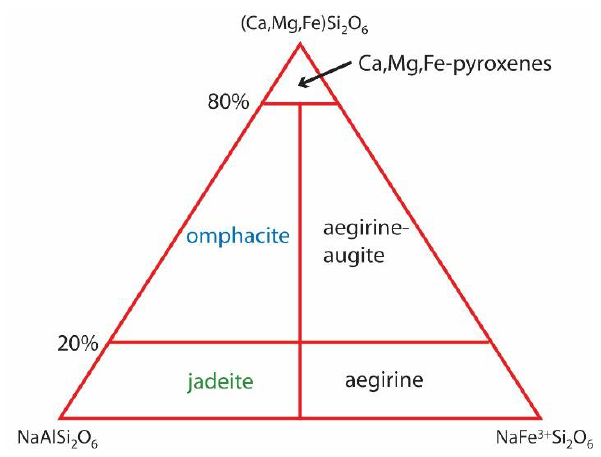
Figure 25. A ternary diagram for Na-bearing pyroxenes shows the relationships between jadeite, omphacite, and other related minerals. omphacite, and other related